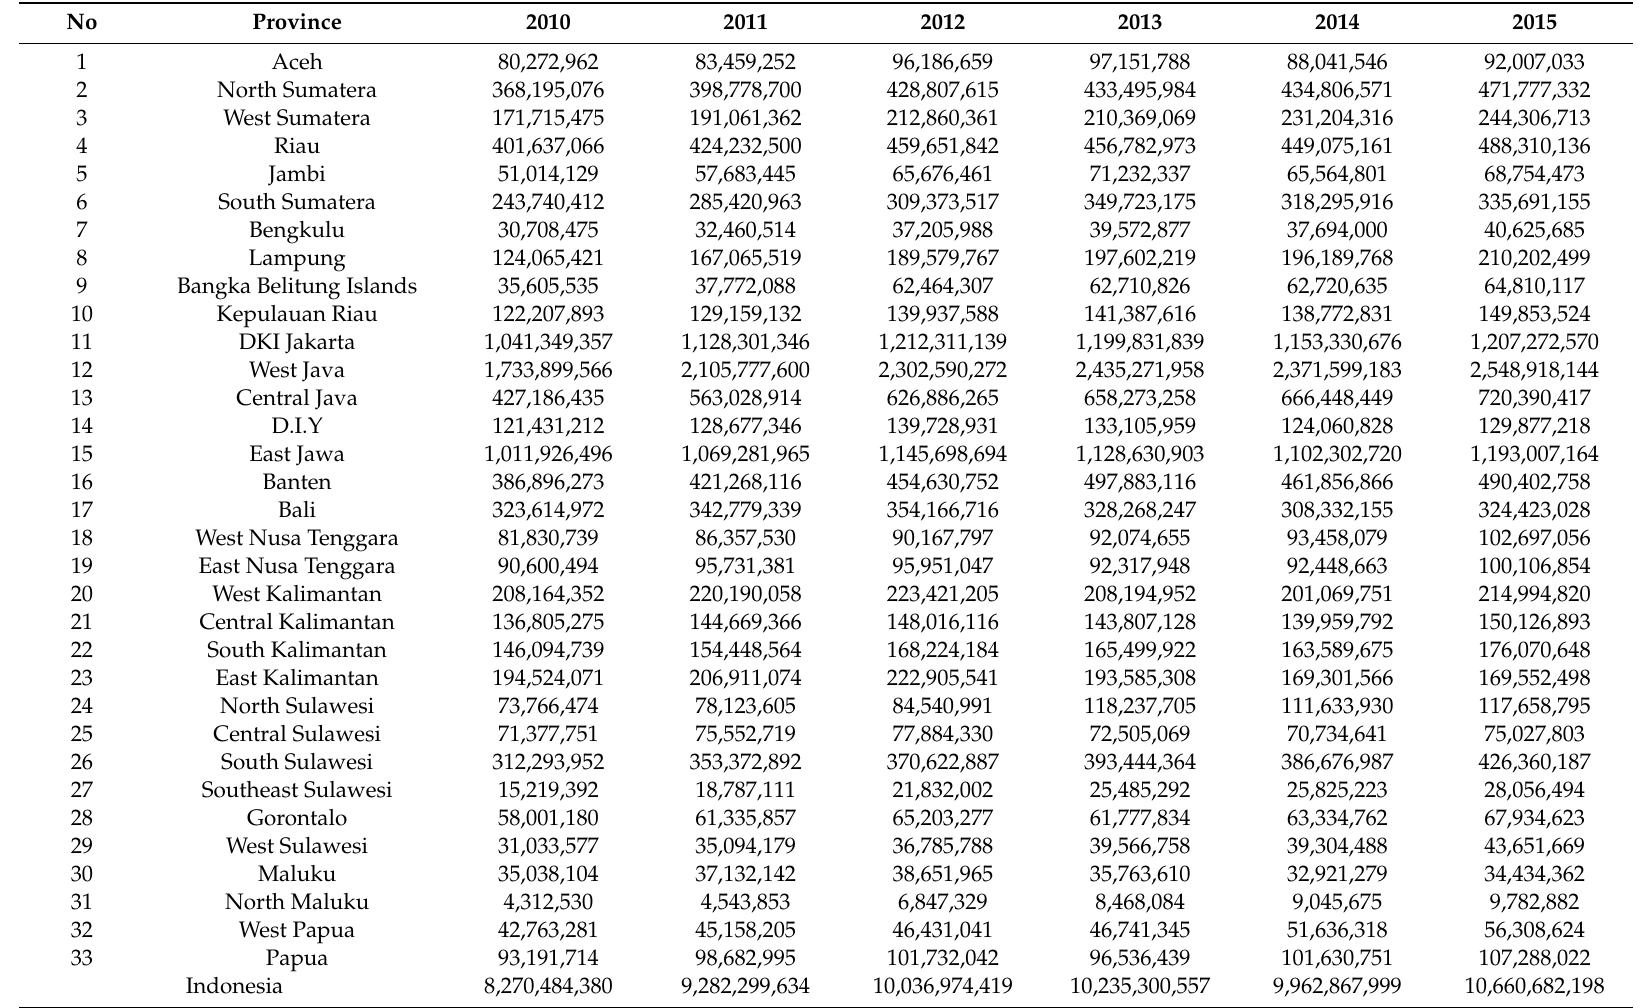
Table 8. Car energy demand among provinces, 2010–2015